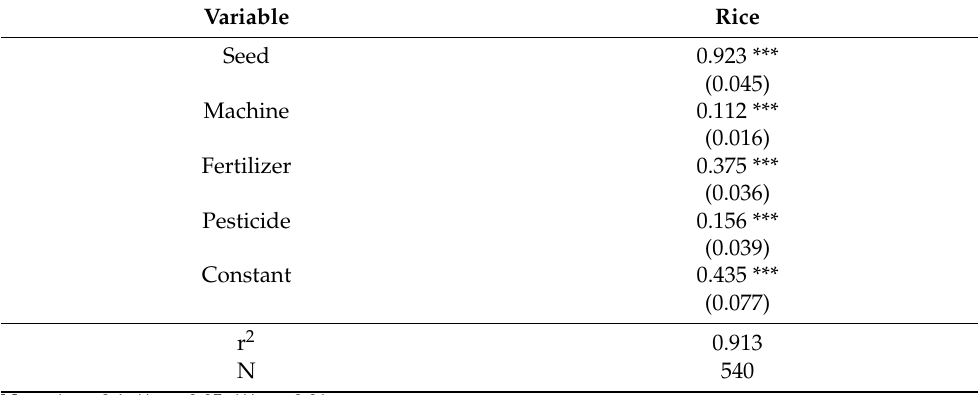
Table 2. Result of regression of C–D production function (log).